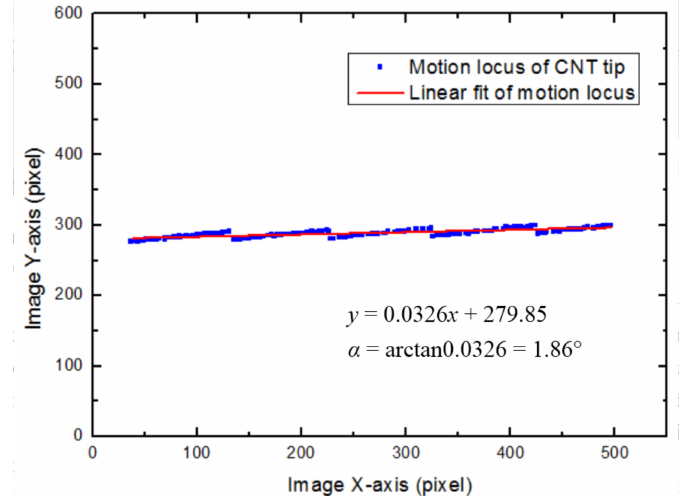
Figure 11. Recording the motion locus of CNT tip vision-based tracking for X-axis, SEM magnification was 15,000 × , the blue dots were the tracking points, and the red line was their linear